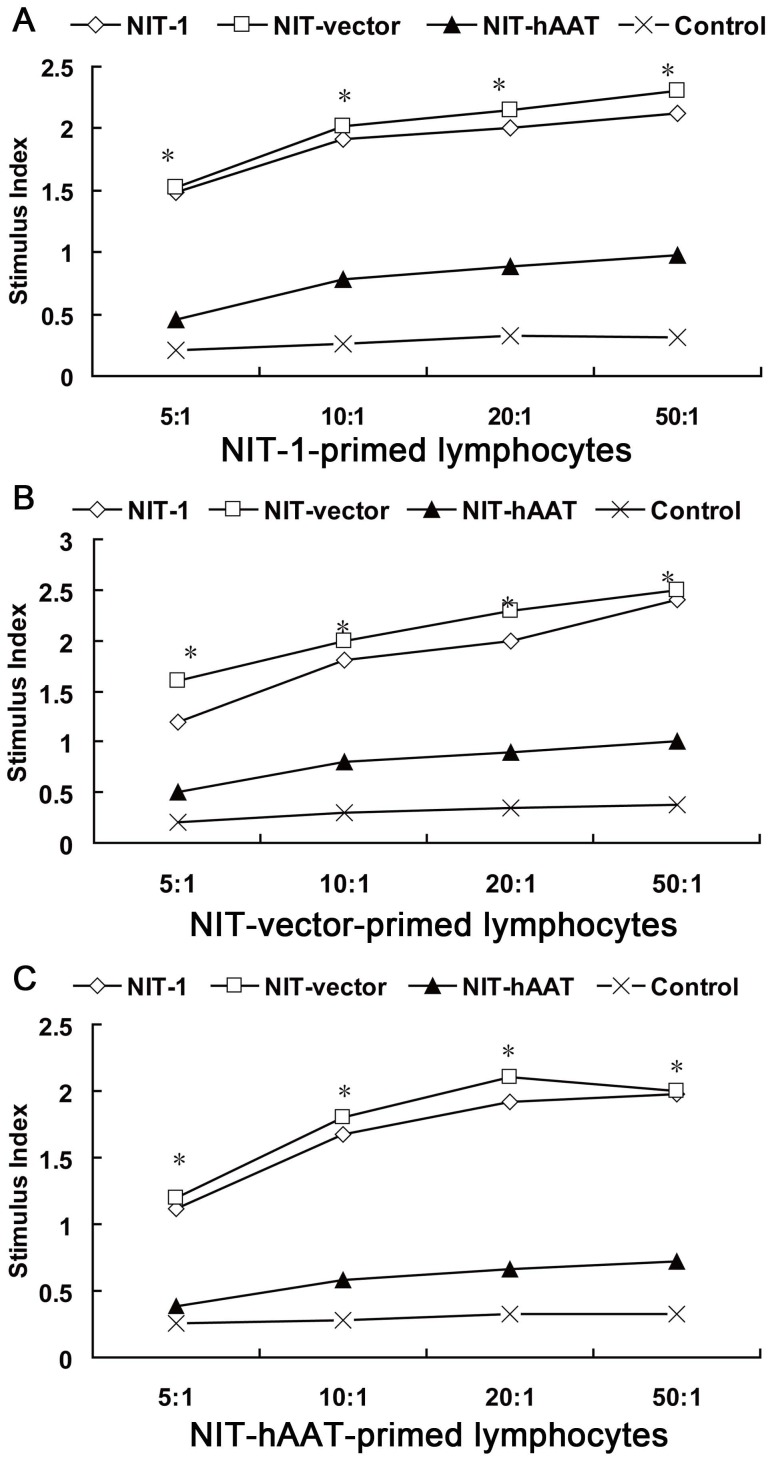
hAAT has protective and immunoregulation dual effects analysed by CTL assay.The effects of hAAT on a β islet cell line were examined via an extended CTL assay in vitro (n = 3). BALB/c mice were immunized twice with NIT-1 or NIT-vector or NIT–hAAT cells, and the splenocytes were collected. These splenoctyes were used as responder cells in a 7 day MLR, while NIT-1 or NIT-vector or NIT–hAAT cells pretreated with mitomycin C were used as stimulator cells. An in vitro CTL assay was later performed using NIT-1 or NIT-vector or NIT–hAAT cells as target cells. Target cells cultured with unprimed splenocytes were utilized as control cells. The stimulation index (SI) of NIT-1 primed lymphocytes co-cultured with NIT-1 or NIT-vector or NIT–hAAT cells (A).The stimulation index (SI) of NIT-vector primed lymphocytes co-cultured with NIT-1 or NIT-vector or NIT–hAAT cells (B), The stimulation index (SI) of NIT-hAAT primed lymphocytes co-cultured with NIT-1 or NIT-vector or NIT–hAAT cells (C). *P<0.05.